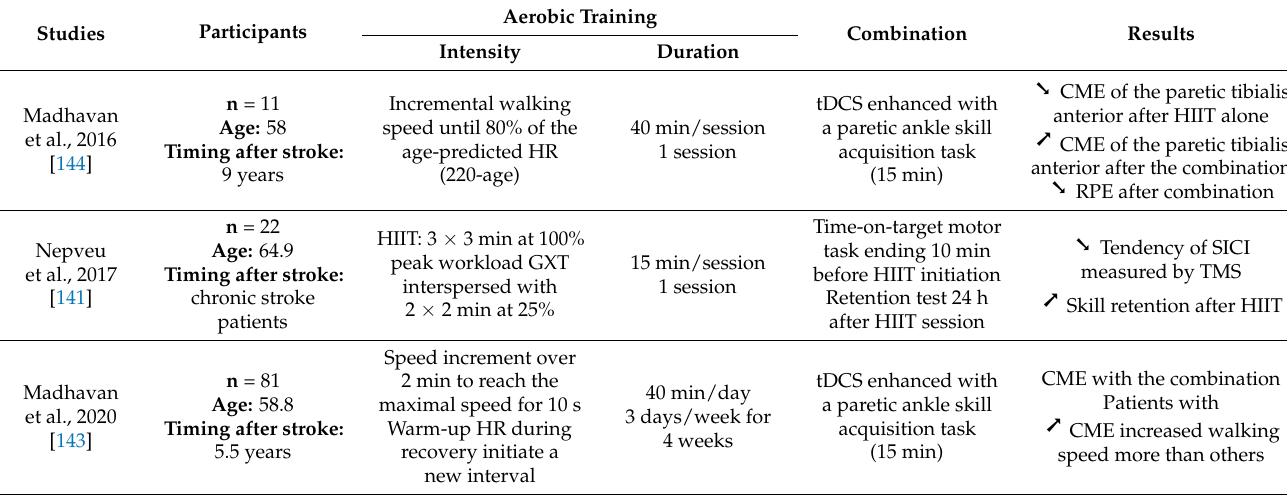
Table 2. Summary of aerobic training protocols and their effects on cognition in poststroke rats. Aerobic Table 1. Summary of aerobic training protocols and their effects on cognition in stroke patient. Studies Participants Aerobic Training Studies Participants